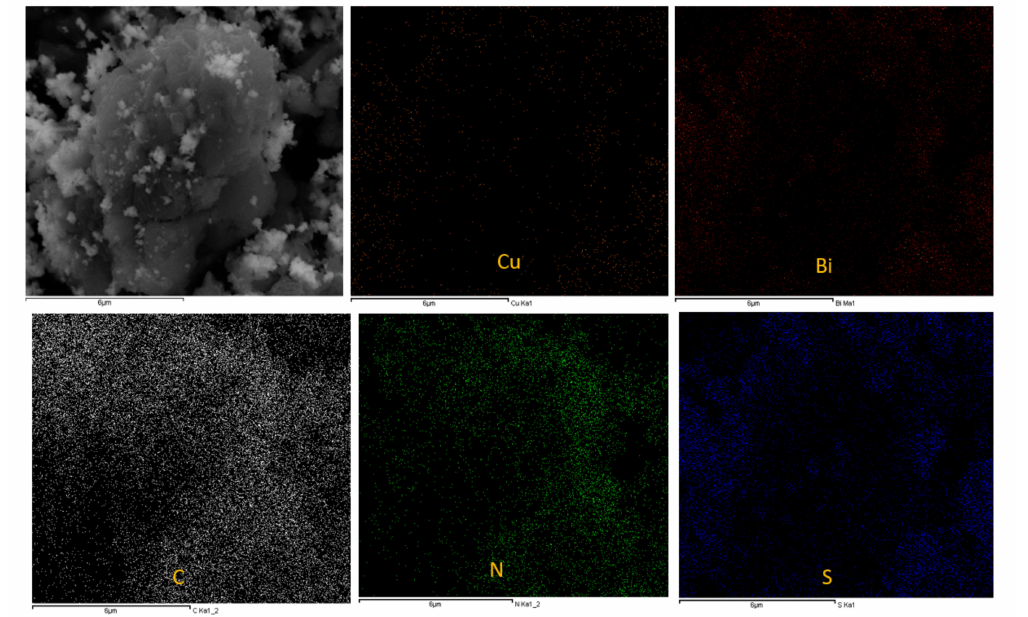
Figure A4. Elemental mapping of Cu 3.21 Bi 4.79 S 9 /g-C 3 N 4 nanocomposite. It shows the distribution of copper, bismuth, sulphur, carbon and nitrogen in the